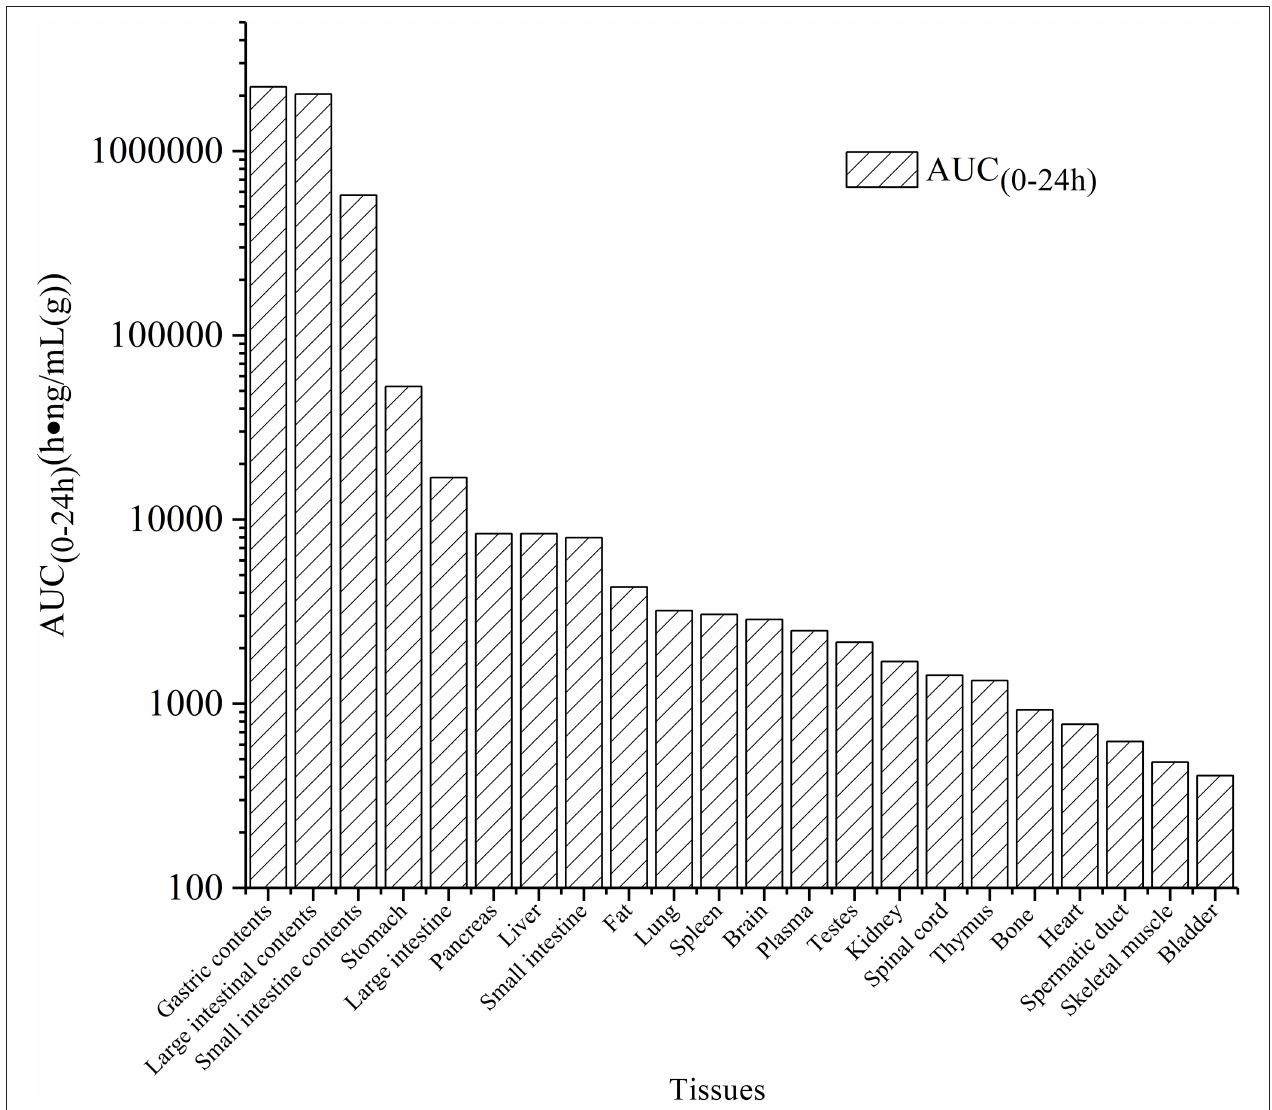
FIGURE 4 | AUC (0 ∼ 24h) values of vitacoxib in different tssue after a single oral gavage dose of 18 mg/kg